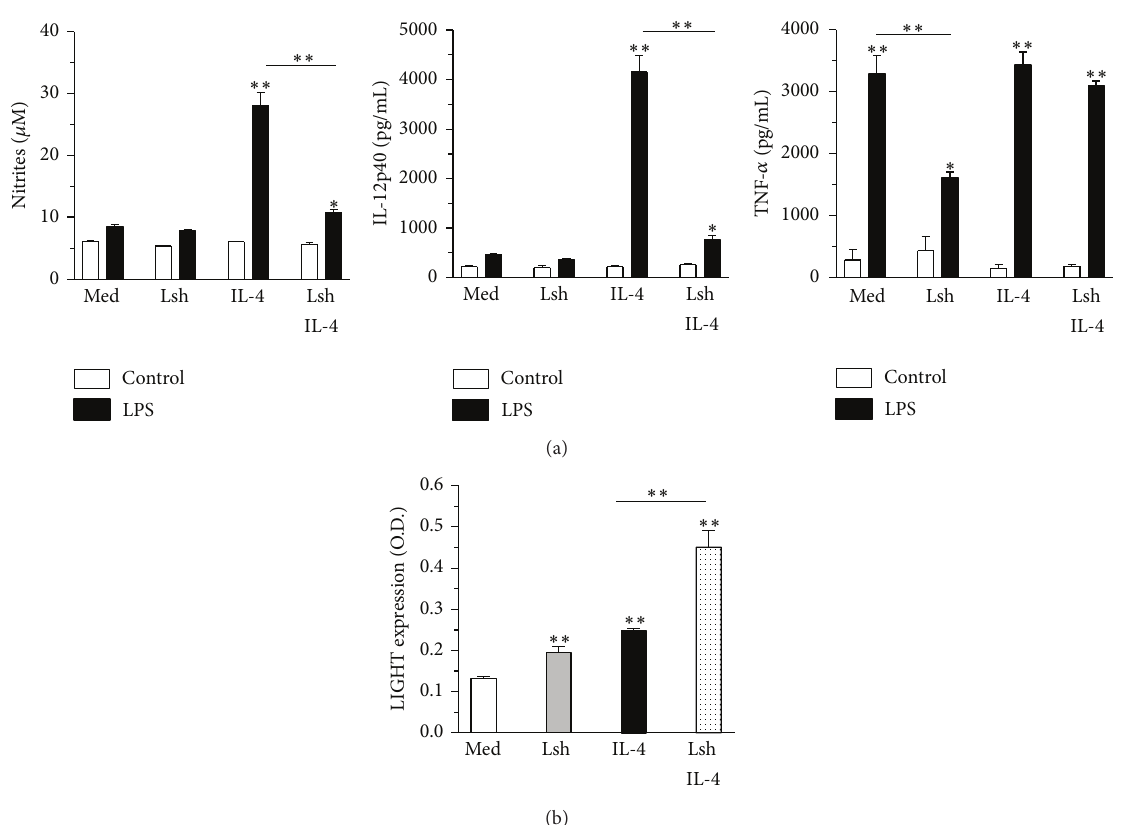
Figure 1: Infection with L. major reduces production of NO and IL-12 and increases expression of M2 marker LIGHT by differentiated macrophages. (a-b) Bone marrow derived macrophages (BMDM from B6 mice) were infected or not with L. major after 6 days. Next day, all BMDM were treated with IFN- 𝛾 , and next day, some of the BMDM cultures were treated with IL-4. (a) After 3 d, cells were washed and restimulated with medium (control) or LPS. After 2 additional days, the levels of nitrites, IL-12p40, and TNF- 𝛼 were determined. (b) After 3 d, expression of LIGHT was evaluated by cellular ELISA. Results are expressed as mean and SE of triplicates (a) or quadruplicates (b), ∗ 𝑃 < 0.05 , ∗∗ 𝑃 < 0.01